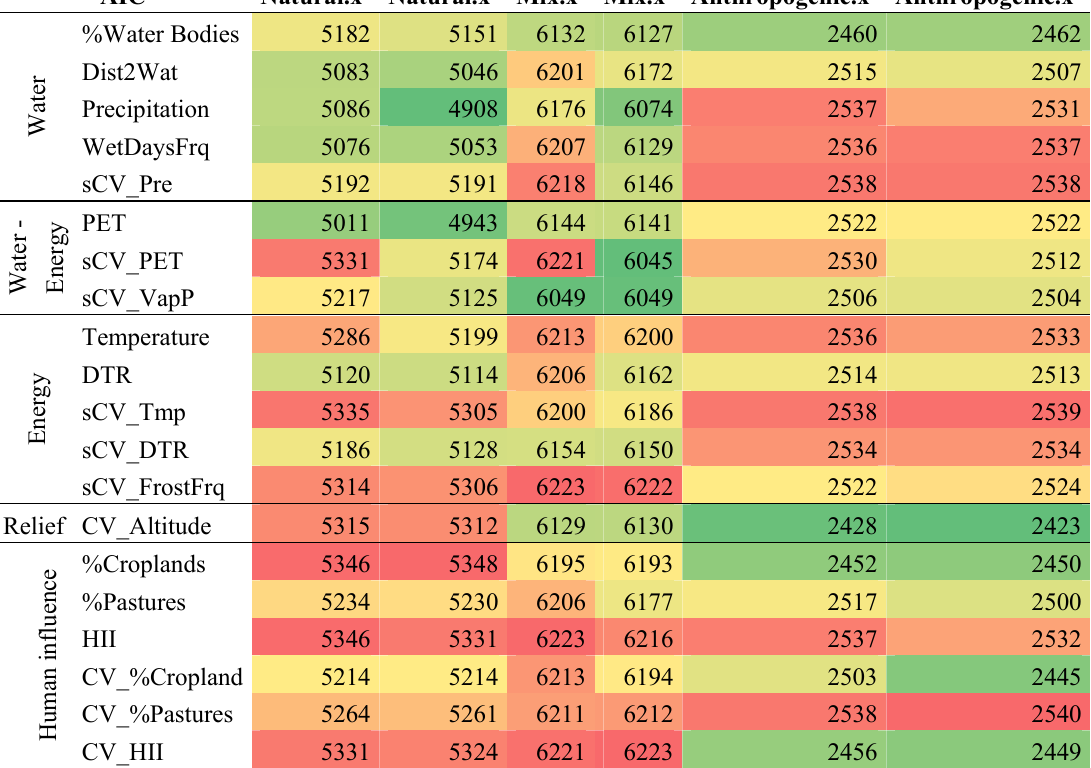
Table 2. Akaike Information Criteria of the different Poisson Generalized Linear Models fitted between EFT richness and each explanatory variable (x 1 column) or its quadratic transformation (x 2 column). Models were compared across a gradient of the Human Influence Index (HII): Natural ecosystems (0 < HII < 10), mixed (10 < HII < 20) and anthropogenic systems (20 < HII < 40). The color scale is used to visualize, in green, those models that showed the lowest AIC values and, in red, the greatest within the same category of human